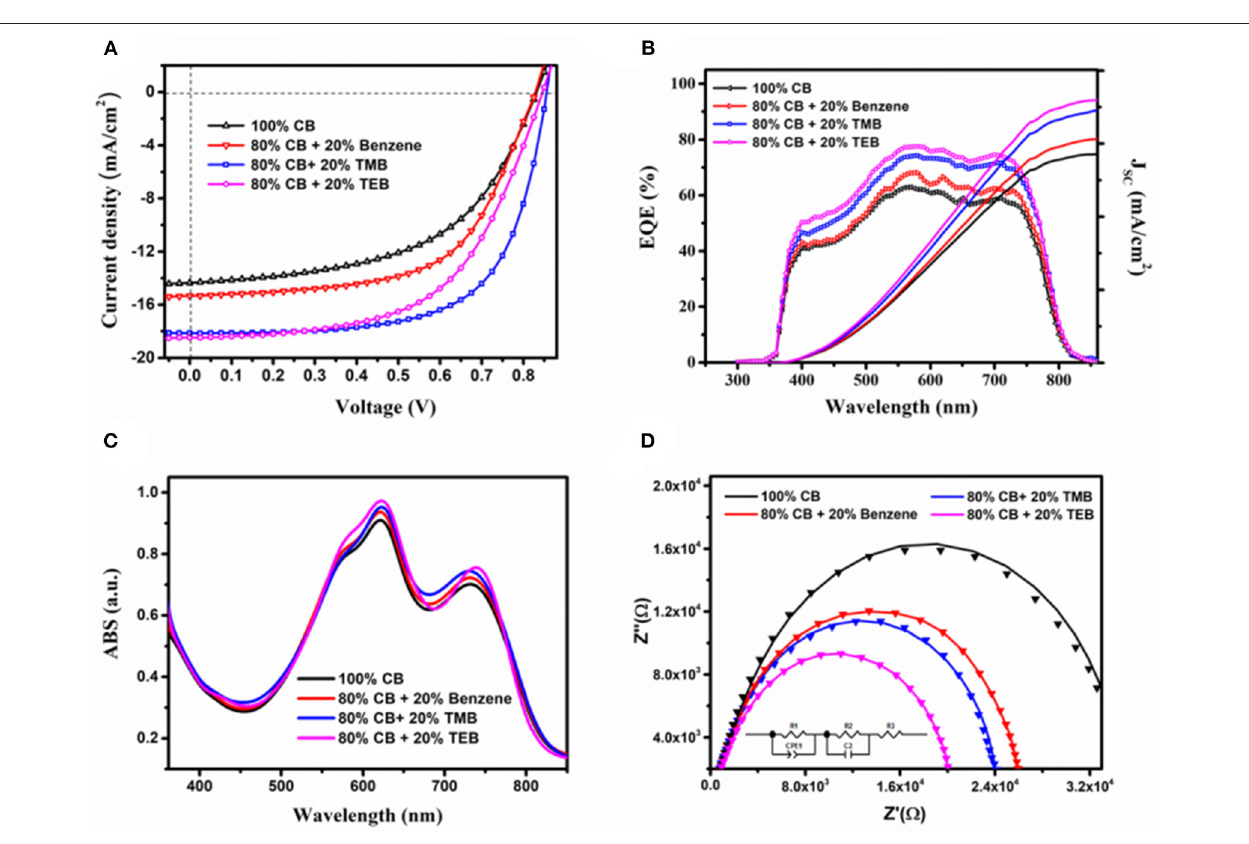
circuit are illustrated in Figure 2C . All parameters calculated from the fitted curves are tabulated in Table 2 . The Cole–Cole plot, which represents the carrier recombination process of